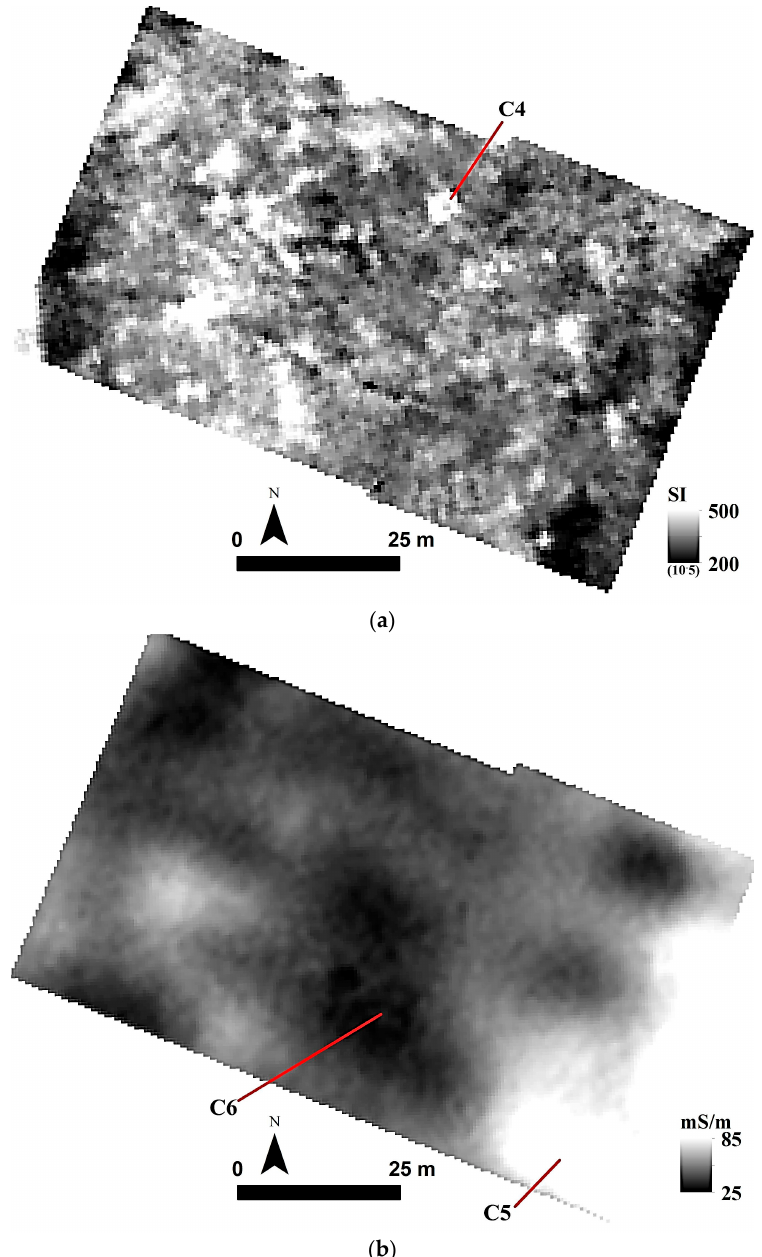
Figure 11. Magnetic susceptibility ( a ); and electromagnetic conductivity ( b ) results from